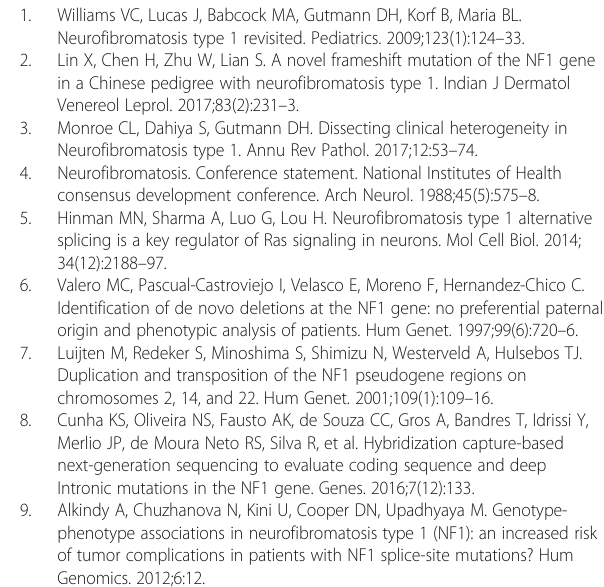
Abbreviations HGMD : Human Gene Mutation Database; HGVS : Human Genome Sequence Variation Society; IRB : Institutional Review Board; MLPA : multiplex ligation- dependent probe amplification; NCBI : National Center for Biotechnology Information; NF1 : neurofibromatosis type 1; PAGE : polyacrylamide gel electrophoresis; PolyPhen-2 : Polymorphism Phenotyping v2; RFLP : restriction fragment length polymorphism; SIFT : Scale-Invariant Feature Transform; SNP : single nucleotide polymorphism; SNV : single nucleotide